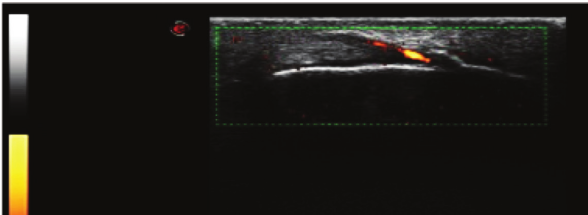
Figure 3: Ultrasound examination showing decreased echogenicity of the tendon, new bone formation at the insertion of the tendon and hypervascularization visualized on Power Doppler exam, indica- ting